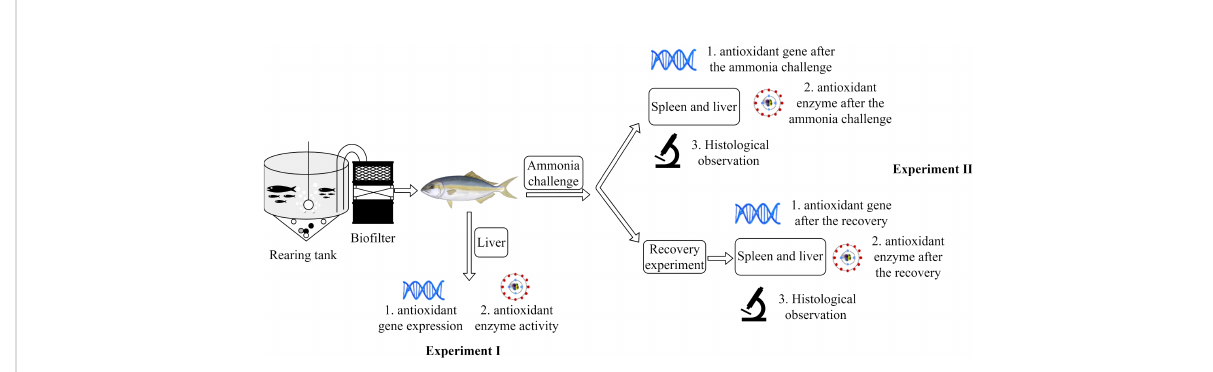
FIGURE 1 The schematic design of the rearing system and measured parameters of the